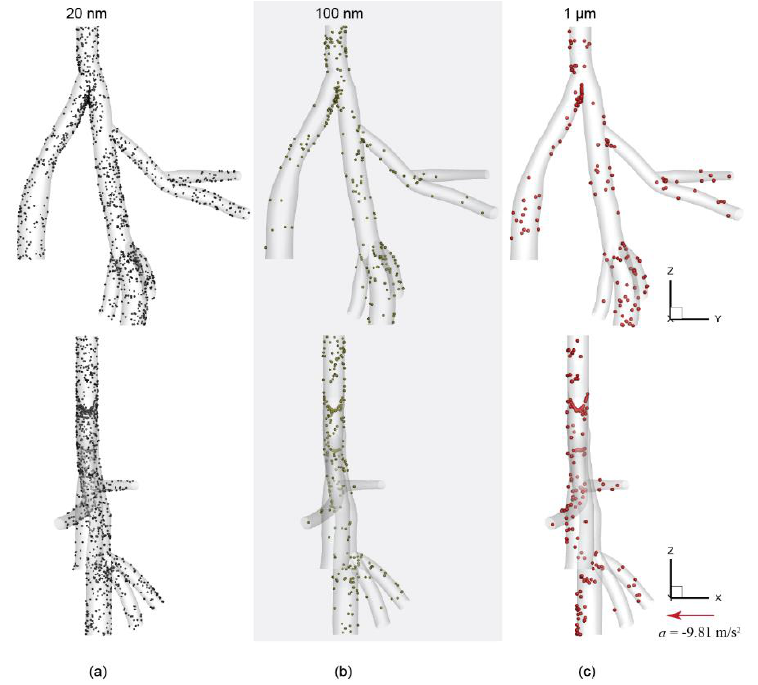
Figure 4. Particle deposition patterns comparison with particle sizes of ( a ) 20 nm, ( b ) 100 nm, and ( c